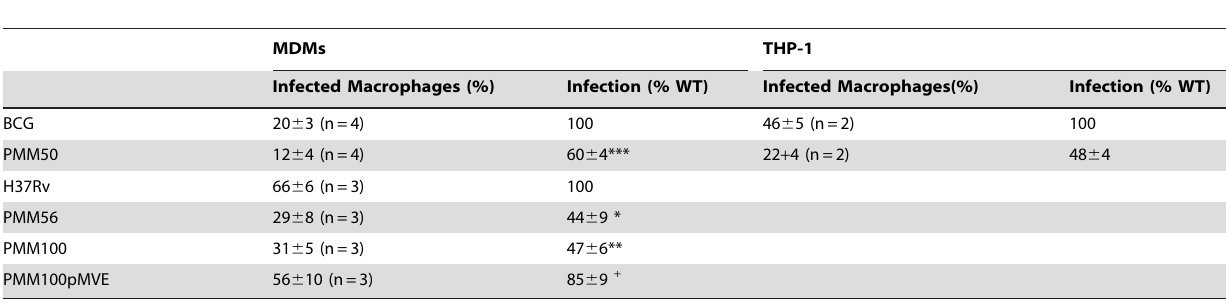
Table 2. ppsE mutation decreases the ability of M. tuberculosis complex strains to infect human